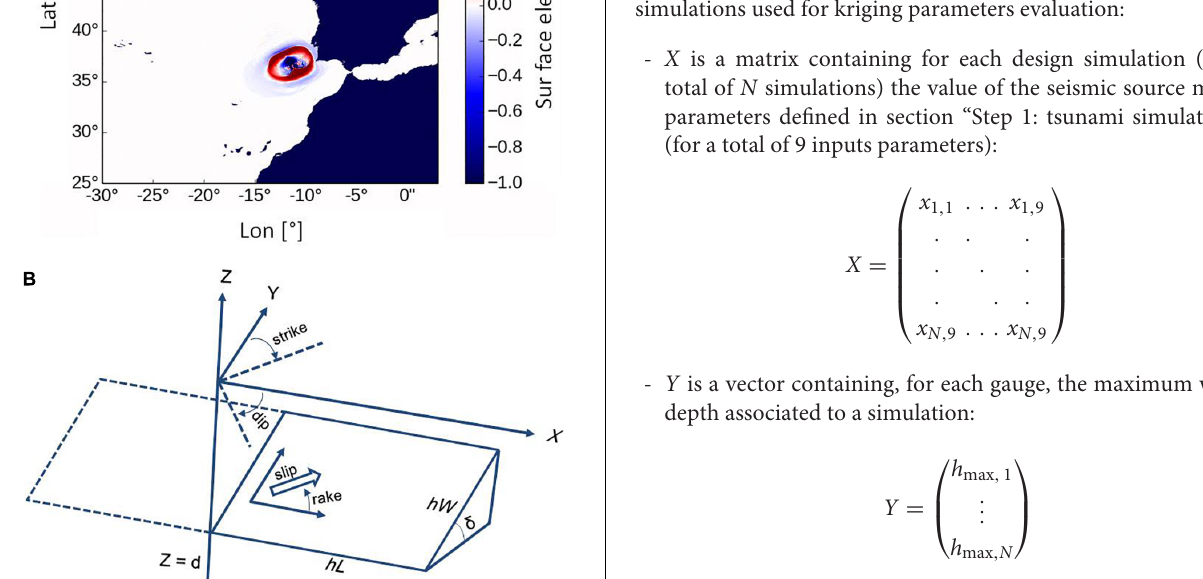
can be defined for x = ( x 1 , ..., x d ) ∈ D ∈ R d as the following Gaussian process “N(.)” :